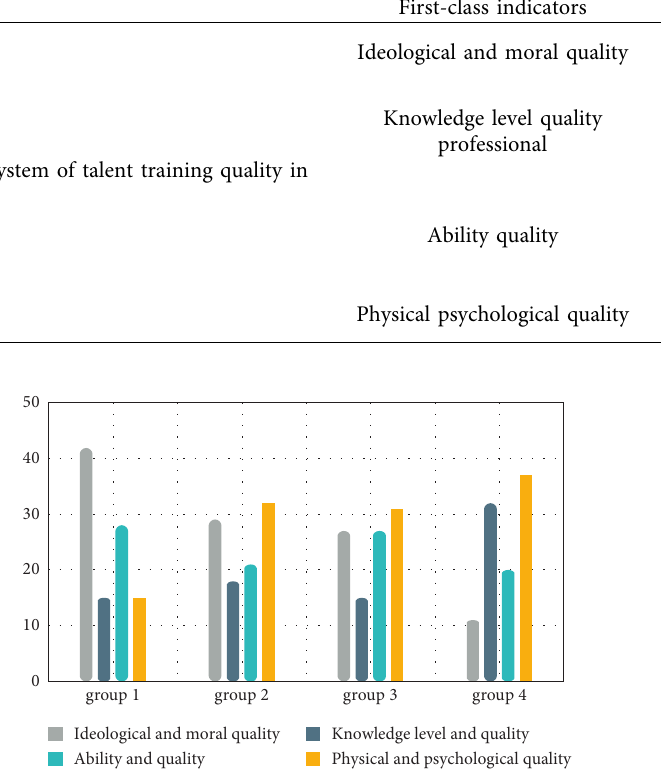
Figure 1: Statistical chart of level 1 indicator survey data. Table 2: Ideological and moral quality.